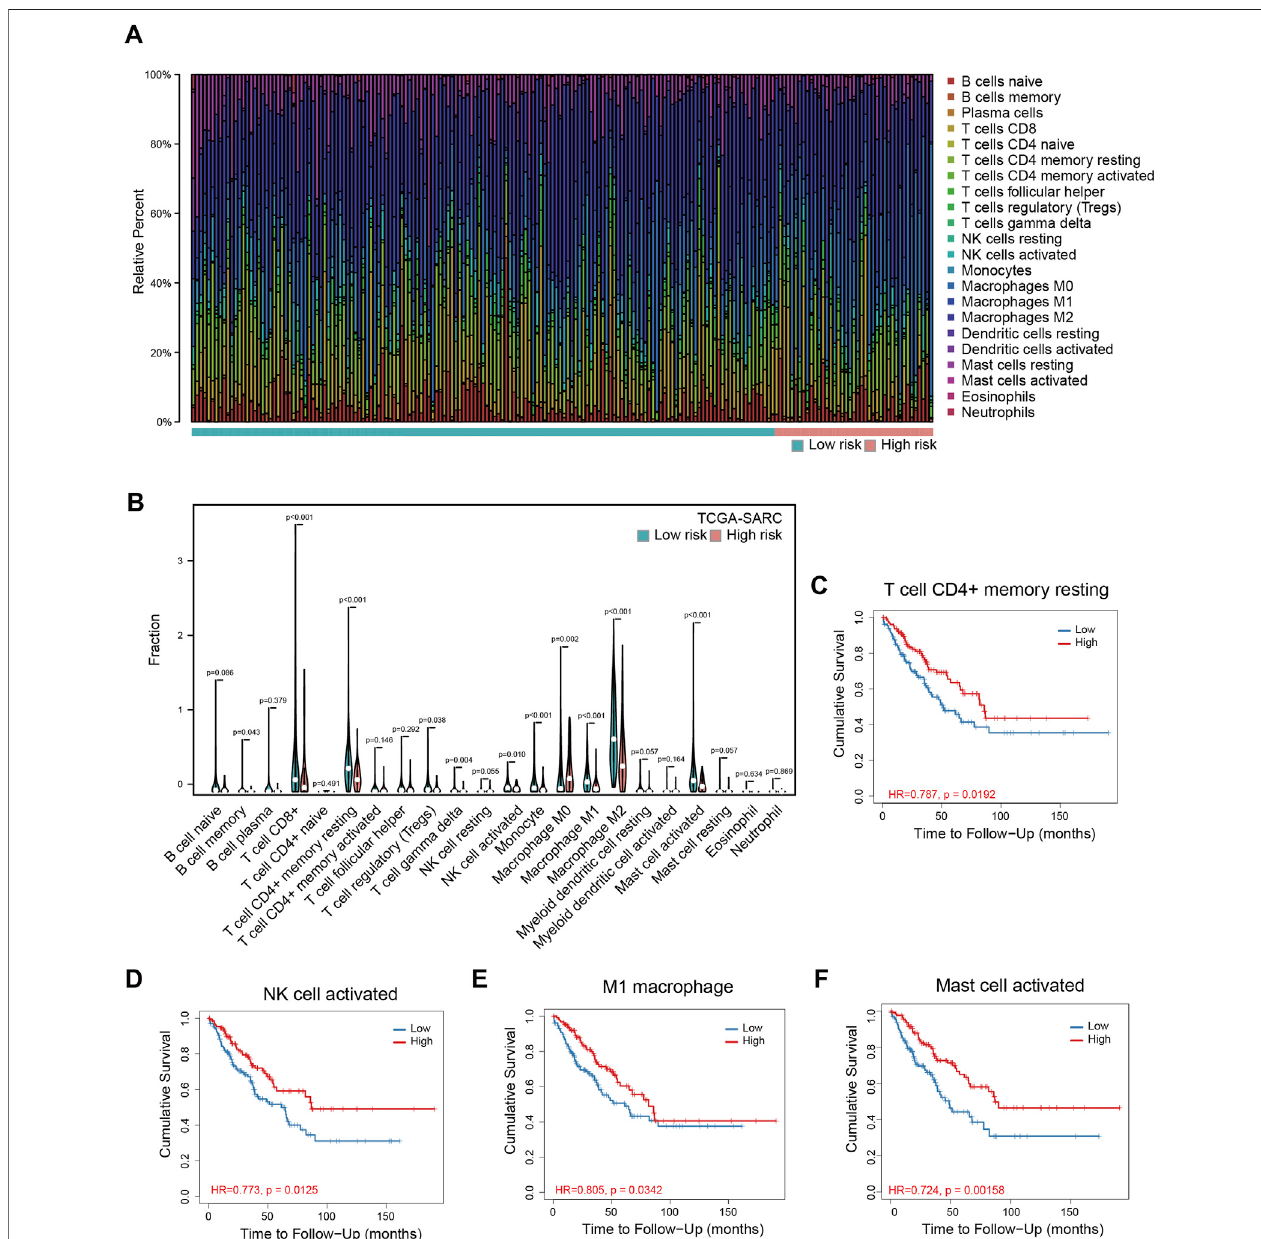
FIGURE 3 | Immune in fi ltration analyses in TCGA-SARC patients. The proportions of 22 immune cells in 256 sarcoma patients (A) and the comparison of their in fi ltration inhigh and low-risk groups (B) . Therelationshipsbetweenoverallsurvivaland restingmemory CD4 + Tcell (C) ,activated NK cell (D) , M1macrophage (E) ,and activated mast cell (F) in these patients. TCGA, The Cancer Genome Atlas; TCGA-SARC, the whole TCGA sarcoma cohort.